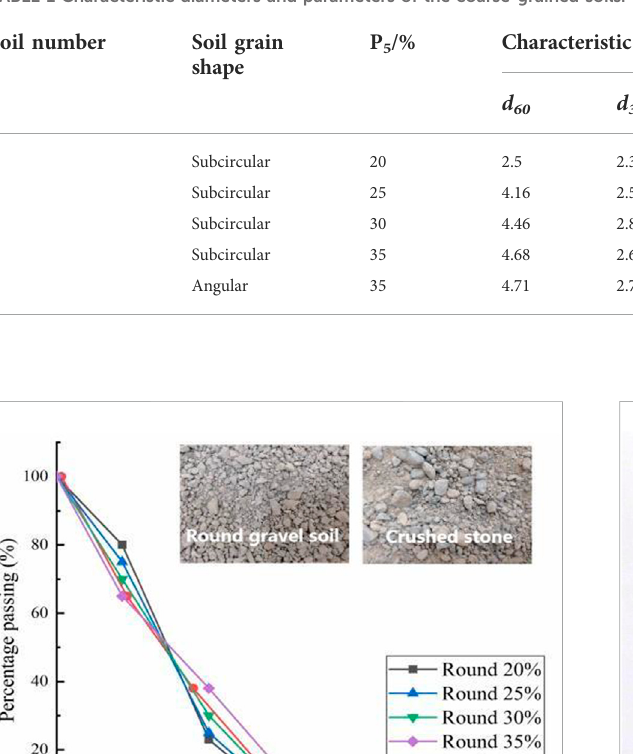
TABLE 1 Characteristic diameters and parameters of the coarse-grained soils.